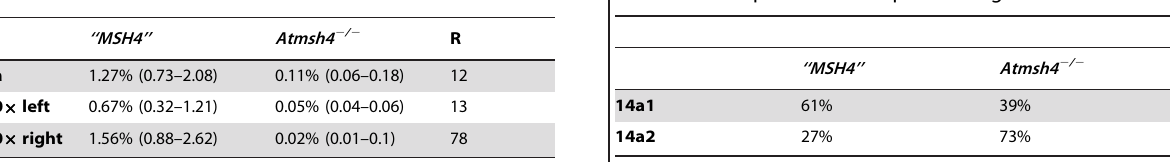
Table 2. Comparison of CO partitioning in 14a1 and